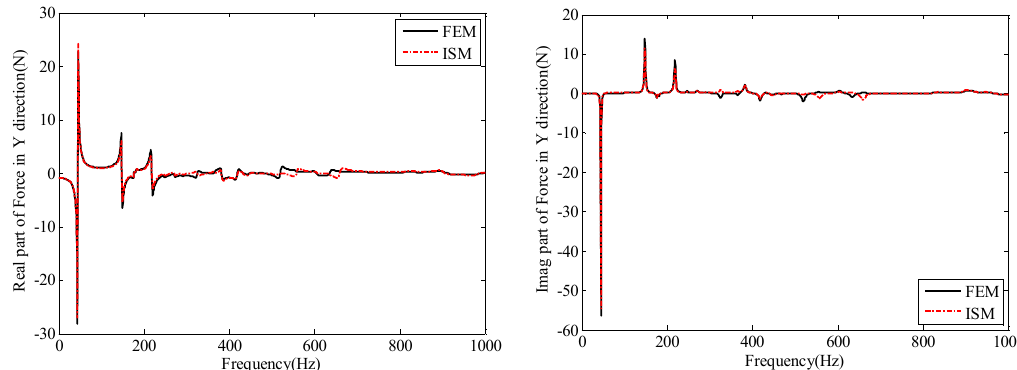
Figure 8. Force comparison of ISM and FEM of point P7 in the Z direction. Table 1. Comparison of the natural frequency with literature. Modes No.